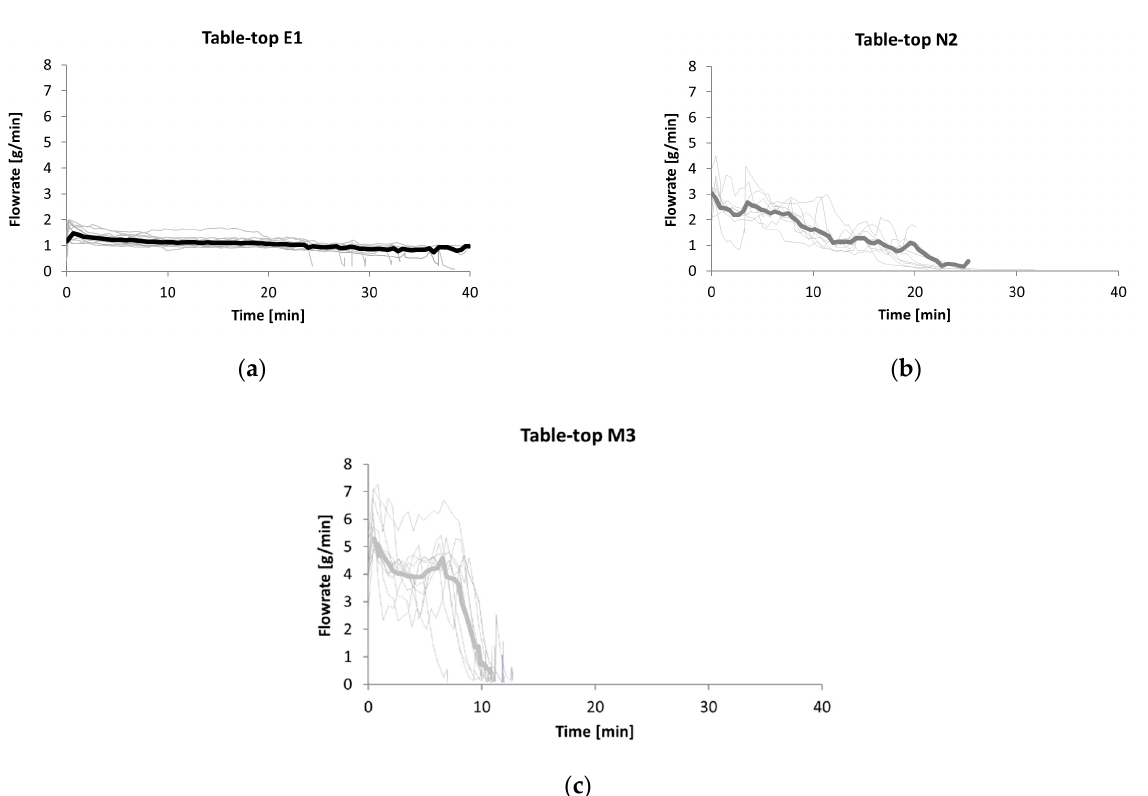
Figure 2. Table-top mean powder consumption (bold line) calculated from 10 repetitions (thin lines). ( a ): Table-top E1, ( b ): Table-top N2; ( c ): Table-top M3.